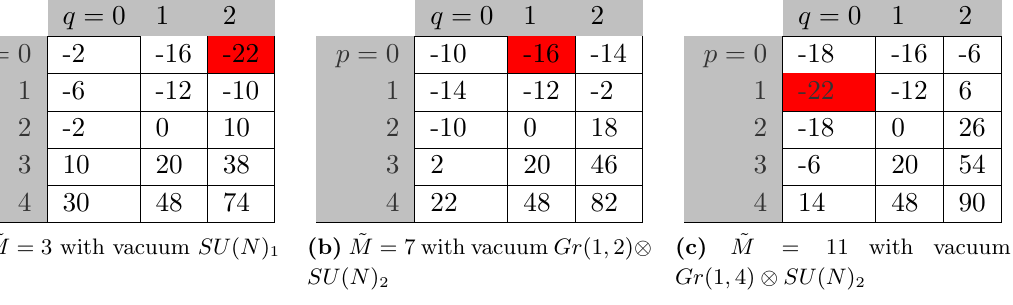
Table 3. Various values of the e(cid:11)ective potential with ~ m = 11. This follows trajectory 3 as shown in (cid:12)gure 6. The minimum is shown in red.